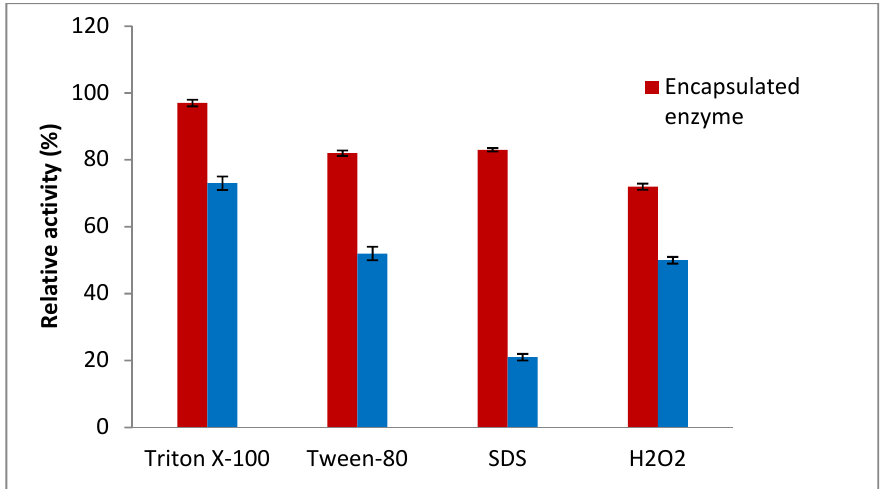
Figure 5. Effect of surfactant and oxidizing agent on enzyme residual